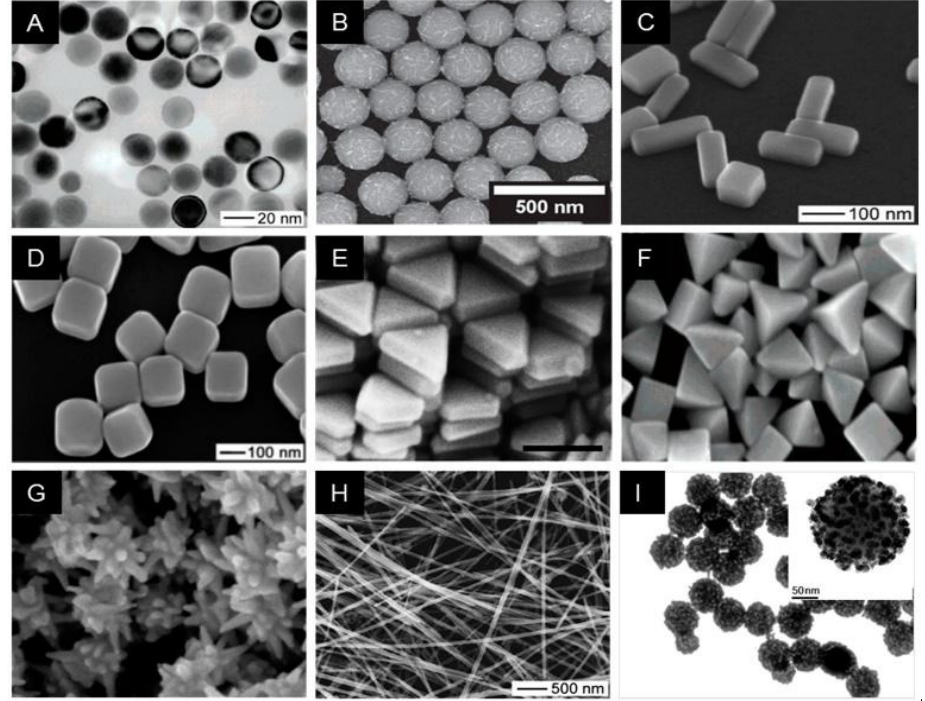
Figure 5. Transmission Electron Microscopy (TEM) images of different AuNPs of different sizes and shapes. ( A ) Silver nanosphere, ( B ) Silver necklaces, ( C ) Silver nanobars, ( D ) Silver nanocubes, ( E ) Silver nanoprism, ( F ) Silver bipyramids, ( G ) Silver nanostar, ( H ) Silver nanowire, and ( I ) Silver nanoparticle embedded silica particle. Reproduced with permission from Lee et al. [87]. Copyright 2019, MDPI.